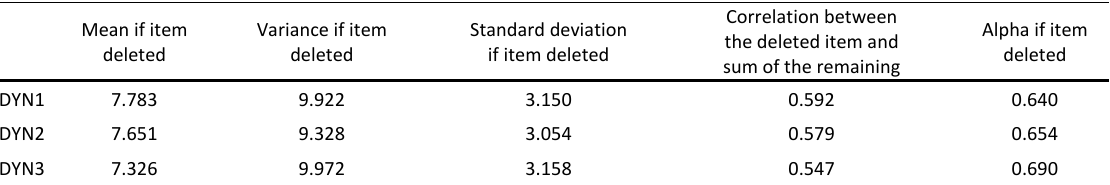
Table 2: Summary of DYN scale